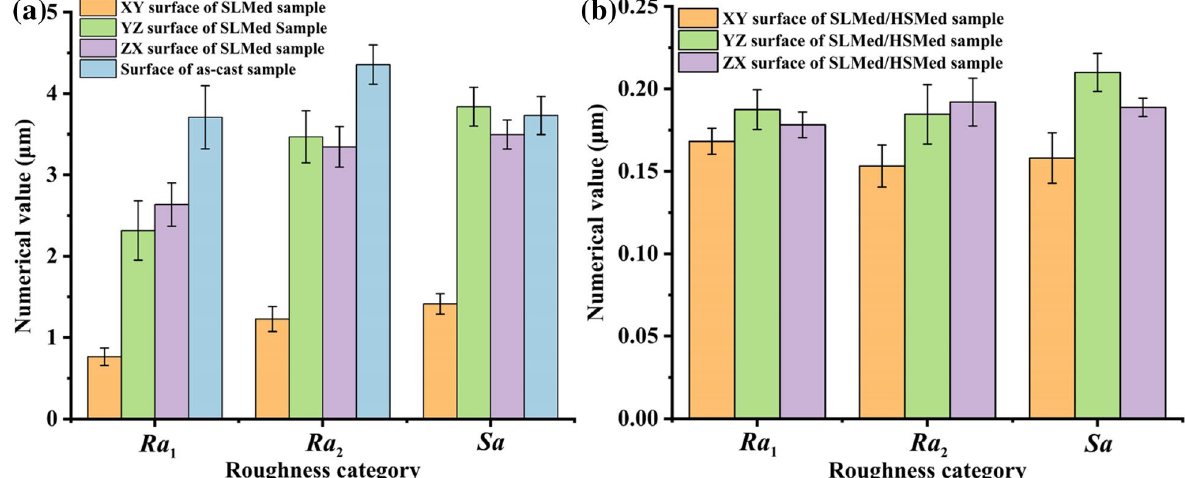
Figure 9 Surface roughness of a the SLMed and as-cast samples; b SLMed/HSMed